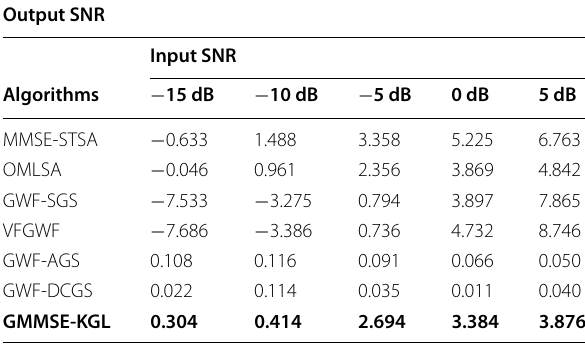
Table 5 The output SNR of different methods for white noise